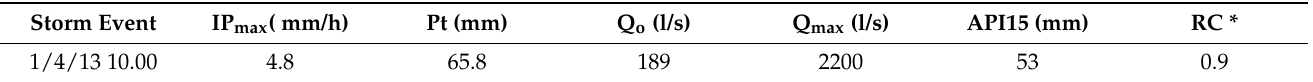
Table 1. Storm flow parameter descriptions: IP max , maximum precipitation intensity; Pt, total precipitation; Q o , discharge before the beginning of the rising limb; Q max , peak flow; API: antecedent precipitation index 15 and 30 days before the peak; RC, runoff